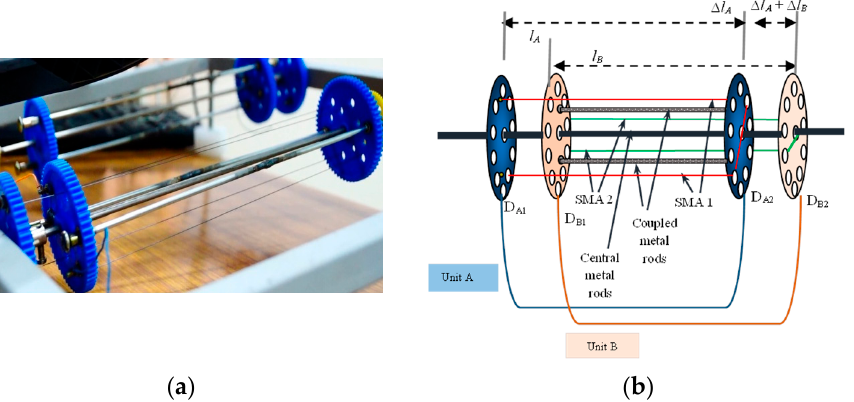
Figure 1. SMA based sensaptic device; ( a ) photograph of the device, ( b ) schematics of the model with labeling.